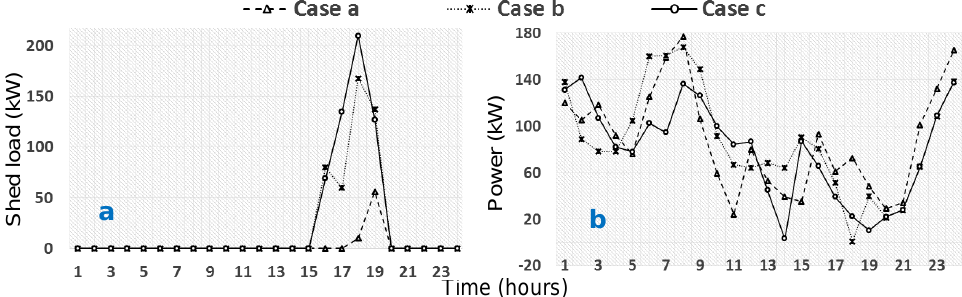
Figure 13. Islanded mode: ( a ) Collective amount of load shed; and ( b ) Internal trading.